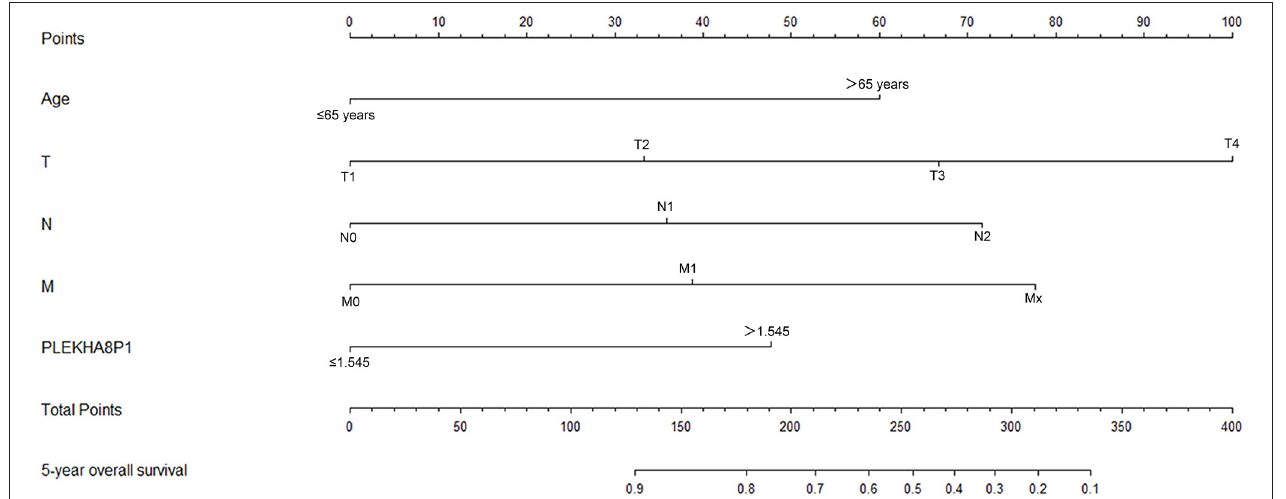
FIGURE 5 | Nomogram of the logistic regression model constructed by age, TNM staging, and PLEKHA8P1.